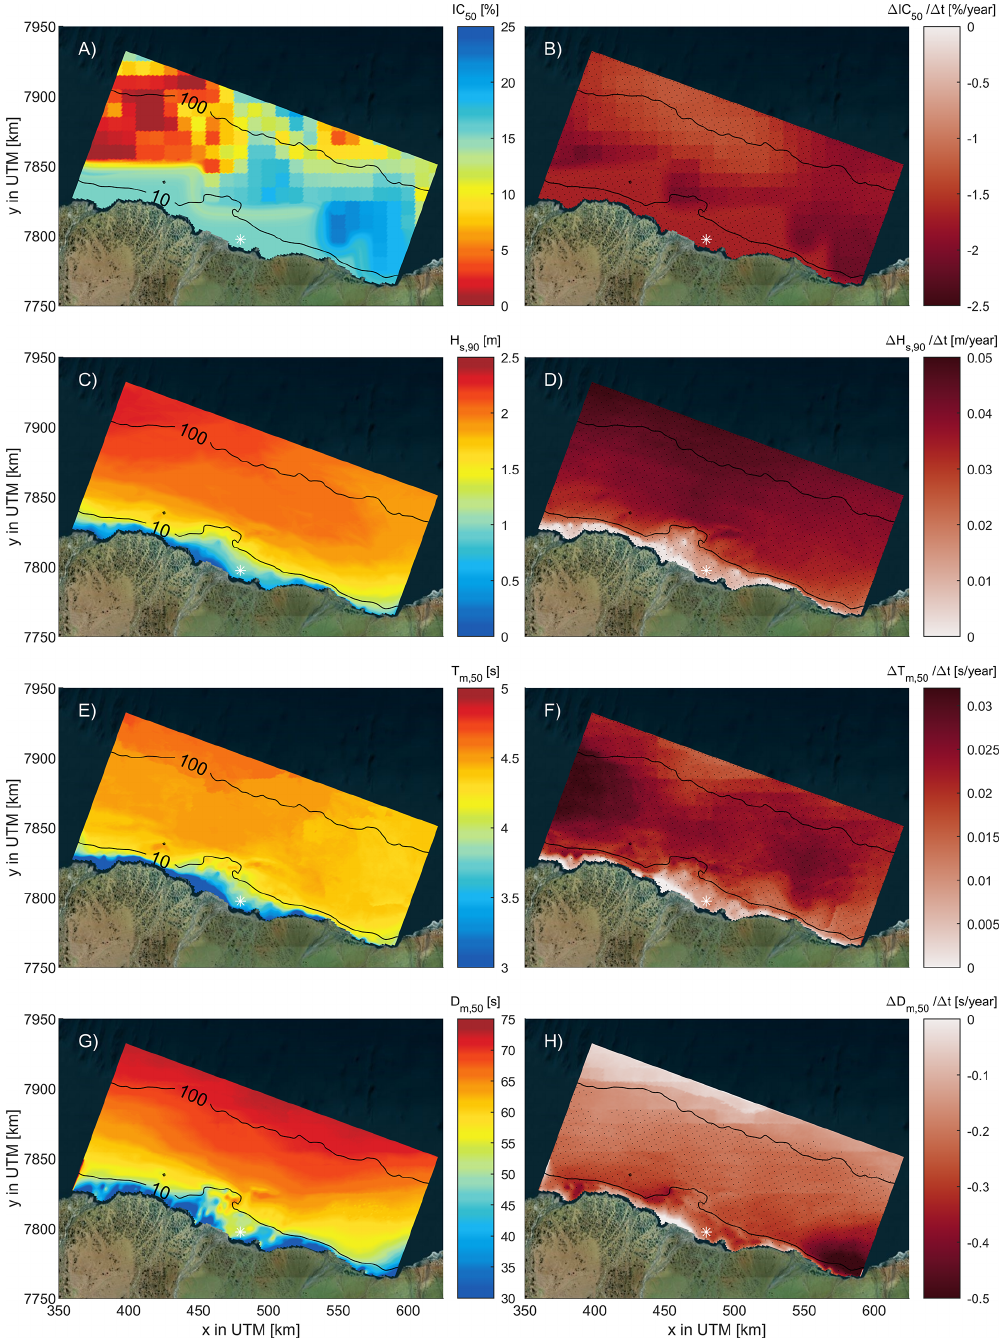
Figure 11. Overview plot of the median value over 41 years of intermediate simulation for ice concentration (IC50; panel a ), 10% exceedance probability wave height ( H s90 ; panel c ), median wave period ( T m50 ; panel e ), and median wave direction ( D m50 ; panel g ). Sen’s trend (panels b, d, f, h ) for the same parameters in the fall season (SON). Statistically significant trends are stippled. Contour lines are the 100 and 10m water depths. The black star is the proposed location for the construction of an artificial island in FIB. © Microsoft Bing Maps.